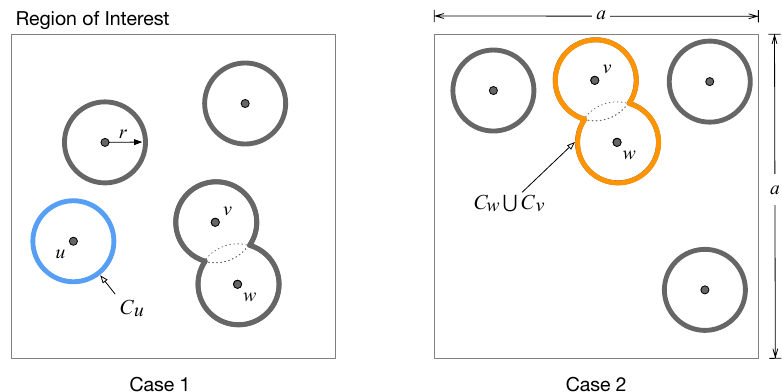
Figure 2. Comparison of two user selection cases, where the left one is more geographically-balancing than the right one, though both can achieve an identical area of total sensing coverage in the square RoI of size a a ×